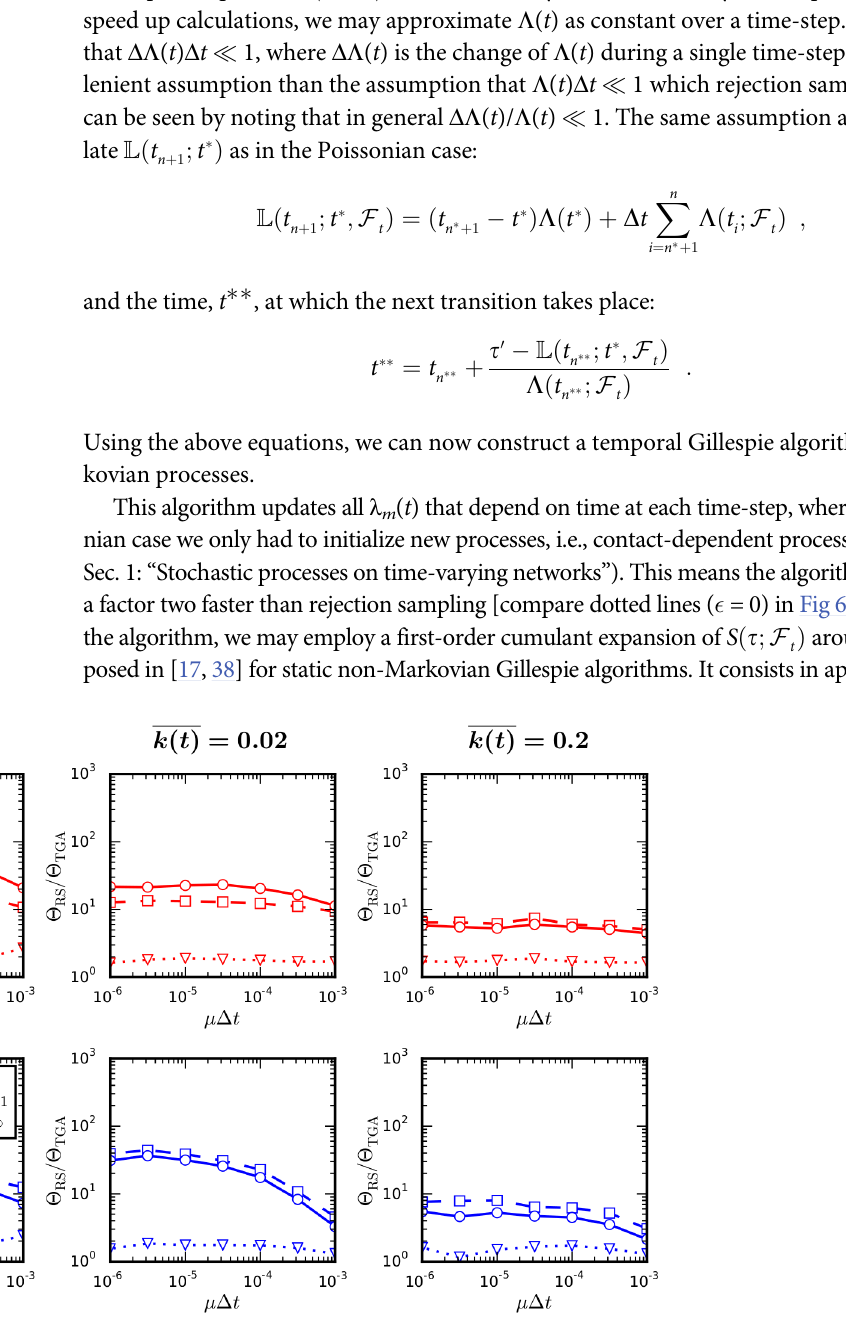
Fig 6. Comparison of the speed of the temporal Gillespie and the rejection sampling algorithms: non-Markovian SIR process. Ratio Θ RS / Θ TGA between the time per realization of a single simulation of an SIR process with Weibull distributed recovery times using rejection sampling and the temporal Gillespie algorithm on activity driven networks of different average degree k ð t Þ [for empirical contact networks, k ð t Þ(cid:9) 0 : 004 (cid:5) 0 : 07 (Table 1)]: (A) for networks consisting of N = 100 nodes and (B) of N = 1 000 nodes. The parameter (cid:2) controls the accuracy of the temporal Gillespie algorithm: for (cid:2) = 0, where λ m ( t ) is approximated as constant over a single time-step, it is most accurate; for (cid:2) ! 1 , where λ m is approximated as constant between two consecutive transition events, it is the least accurate. Node activities were given by a i = η z i with z i (cid:4) z (cid:5) 3 : 2 i for z i 2 [0.03, 1); a node formed two contacts each time it was active. The recovery rate of an infected node was given by Eq (23) with γ = 1.5. The infection rate was β = 10 3 μ 0 for networks with k ð t Þ¼ 0 : 002 , β = 10 2 μ 0 for networks with k ð t Þ¼ 0 : 02 , and β = 10 μ 0 for networks with k ð t Þ¼ 0 : 2 m 0 . (See Methods for details on how simulations were